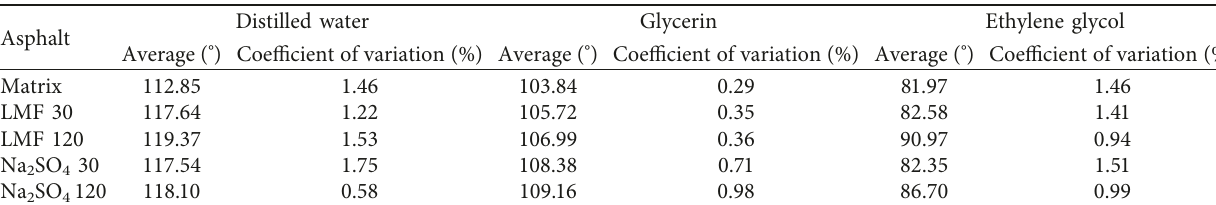
Figure 2: Freeze-thaw cycle test in the environmental cabinet. Table 5: Contact angle between asphalt mastic and liquids.